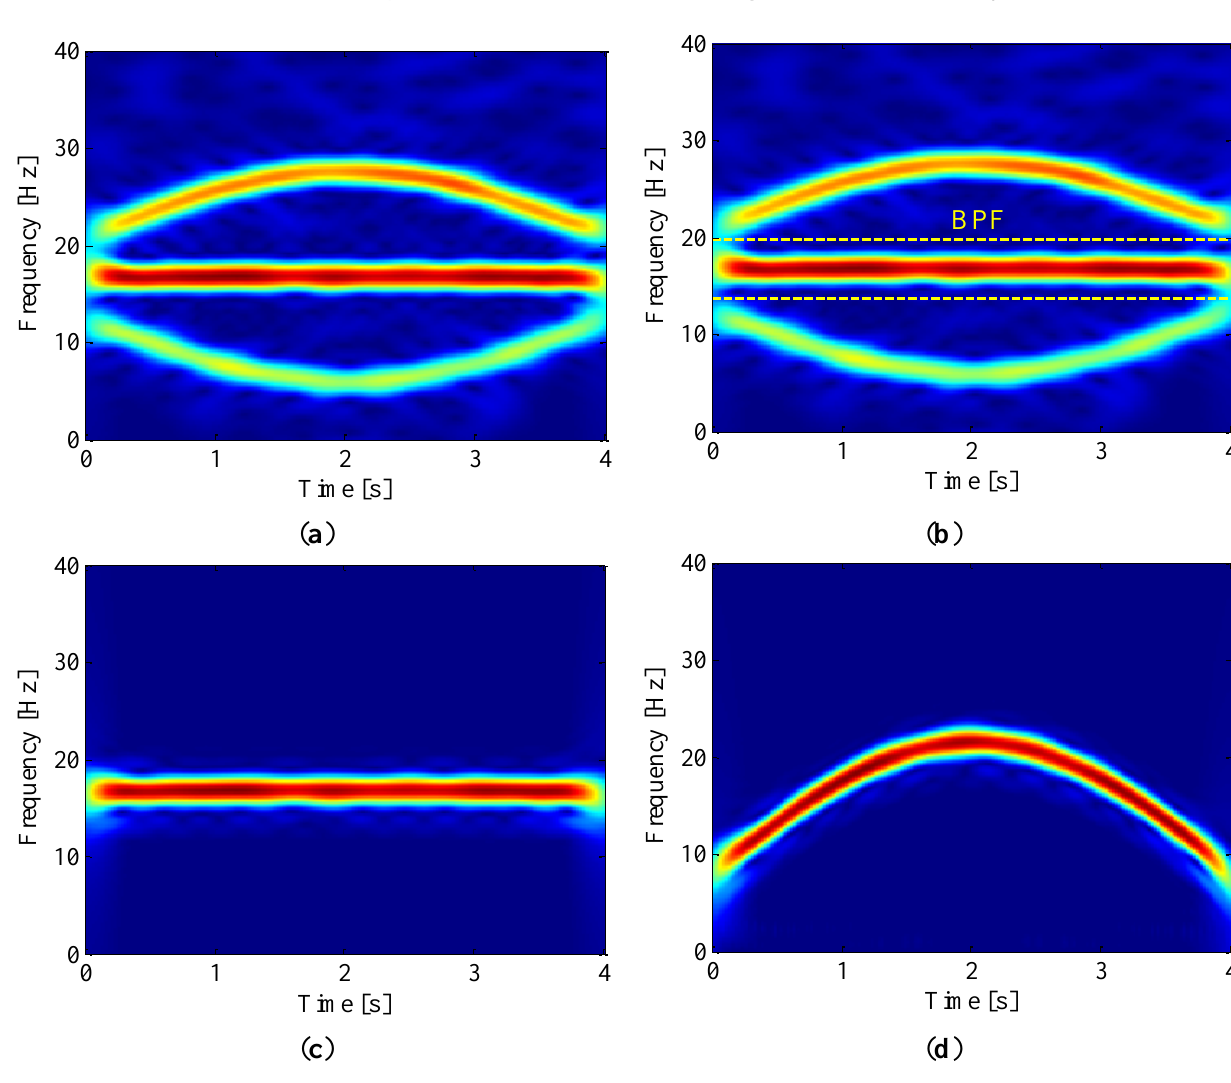
Figure 8. Extracting the 2nd harmonic by generalized demodulation: ( a ) Spectrogram of the generalized Fourier transformed signal; ( b ) Extracting the 2nd harmonic by BPF; ( c ) The 2nd harmonic is separated after BPF; ( d ) Restoring the 2nd harmonic by inverse